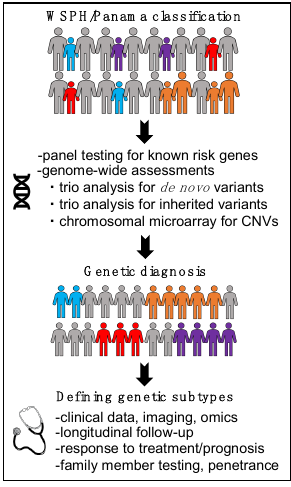
Figure 4. Genomic approach to improve understanding of pediatric PAH.